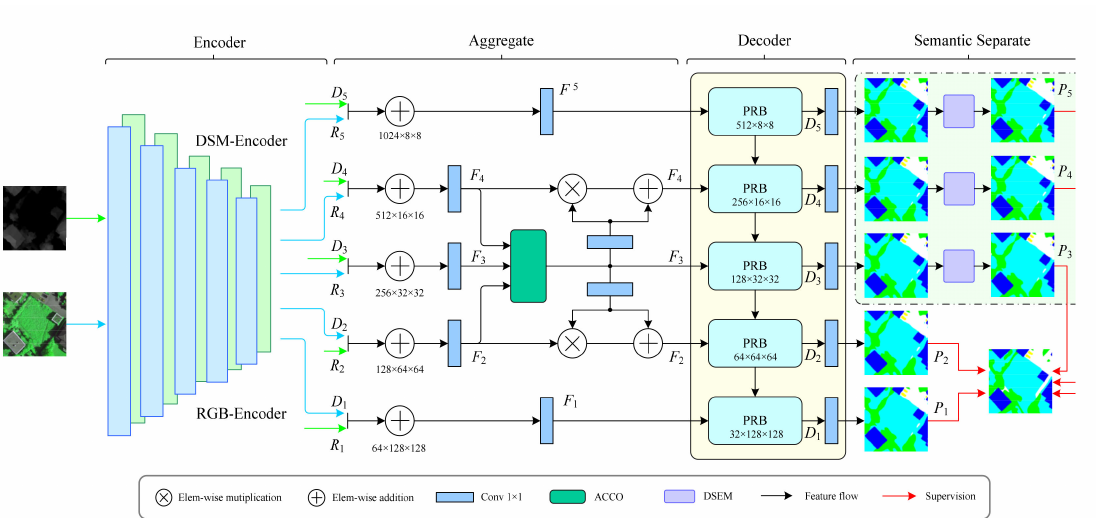
Figure 1. Overall architecture of the proposed DGPRNet. The network includes four stages: encoding, feature aggregation, decoding, and semantic